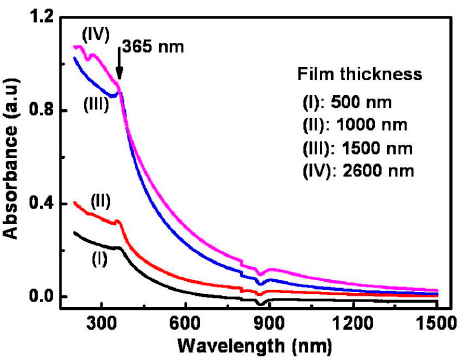
Figure 9. Influence of film thickness on the response of porous ZnO thin film towards NO 2 at room temperature under UV irradiation. Reproduced with permission from [43].